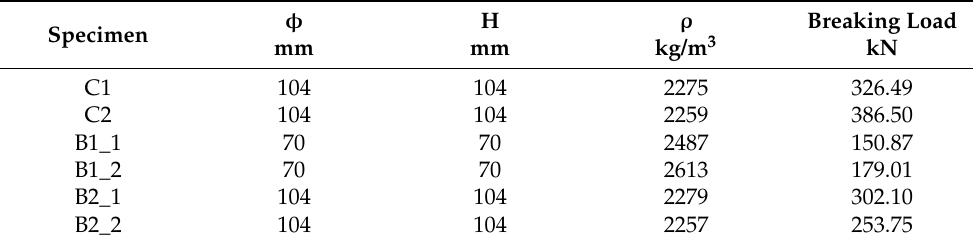
Table 2. Data related to compressive strength measurements.